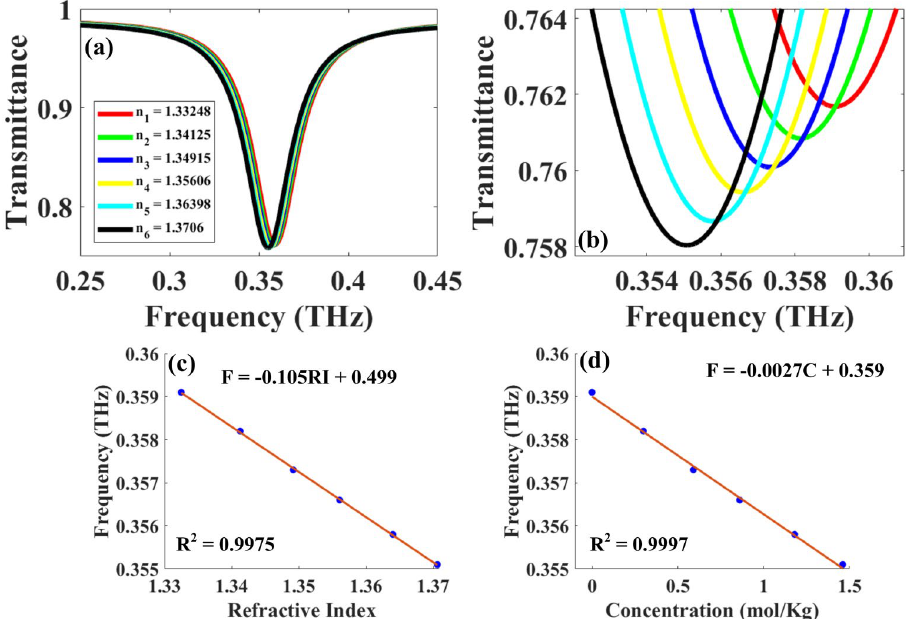
Figure 4. Detection of Cu 2+ contaminated water by employing developed graphene-metasurface- inspired sensor, ( a ) transmittance getting affected by increasing the concentration of Cu 2+ in water from 0 mol/kg to 1.46 mol/kg, ( b ) transmittance response moving left and transmittance drop increment is observed as the Cu 2+ contamination in water is increased, and as a result of the RI of water solution also increase from 1.32348 to 1.3706, ( c ) the curve fitting for RI vs. resonance frequency at which the transmittance drop is achieved for that particular RI, a linear fit with R 2 score of 0.9975 is obtained, ( d ) the curve fitting for concentration vs. resonance frequency at which the transmittance drop is achieved for that particular concentration, a linear fit with R 2 score of 0.9997 is obtained.